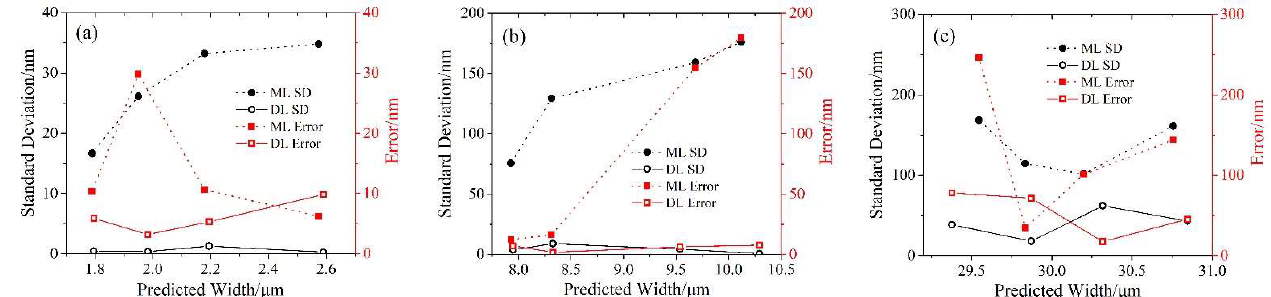
Figure 8. Standard deviation and error of width results for widths around ( a ) 2 μm, ( b ) 10 μm, and ( c ) 30 μm, predicted by machine learning model (dot line) and deep learning model (solid line). ML, machine learning; DL, deep learning; SD, standard deviation.